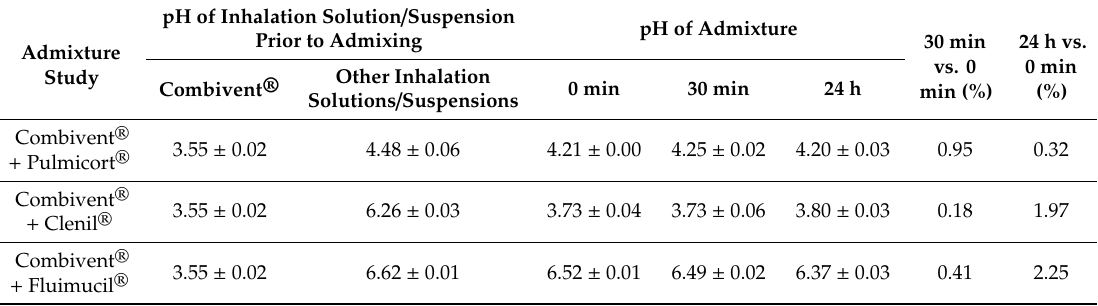
Table 3. Change percentage of the pH value due to inhalation solution / suspension admixtures at di ff erent time points.